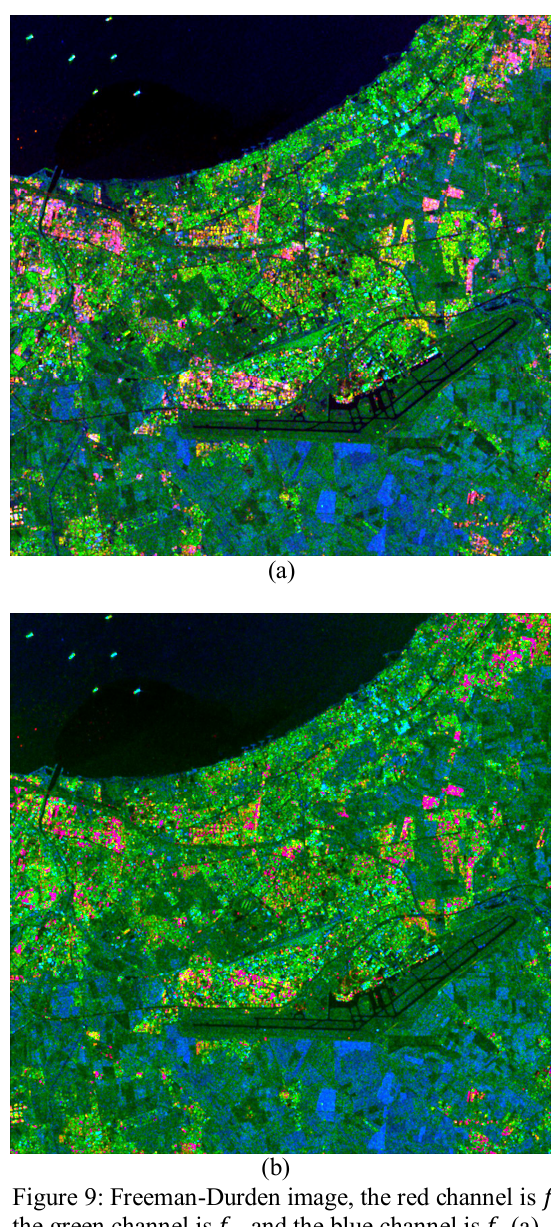
Figure 9: Freeman-Durden image, the red channel is (cid:1858) (cid:3031) , the green channel is (cid:1858) (cid:3049) , and the blue channel is (cid:1858) (cid:3046) (a) RGB-full polarimetric image. (b) RGB-compact polarimetric